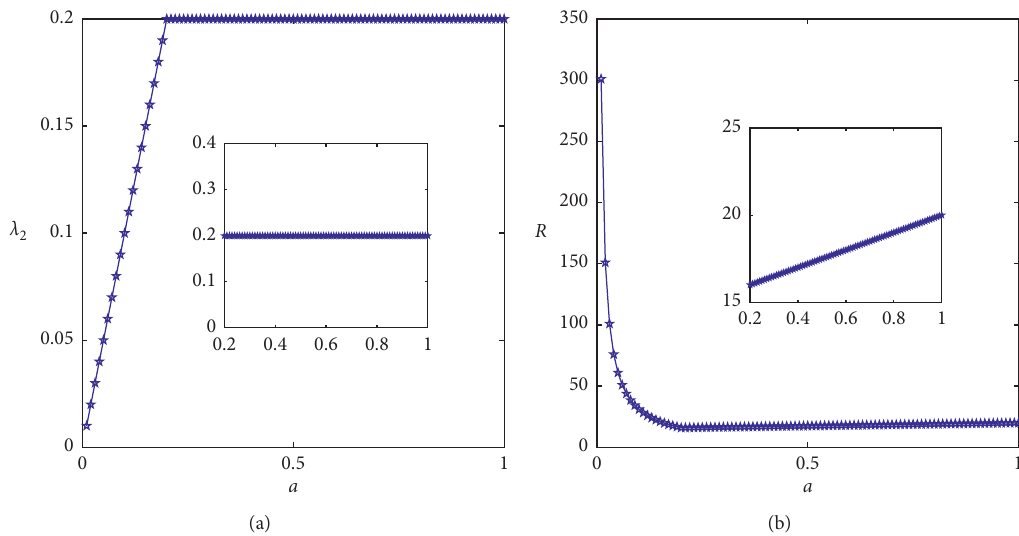
Figure 2: When N is odd, the synchronizability of Network I changes with the intralayer coupling strength a from the leaf nodes to the hub nodes. (a) λ changes with a ( a changes from 0.01 to 1) (subgraph: λ 2 changes from 0.01 to 1) (subgraph: R changes with a ( a changes from 0.2 to 1)).